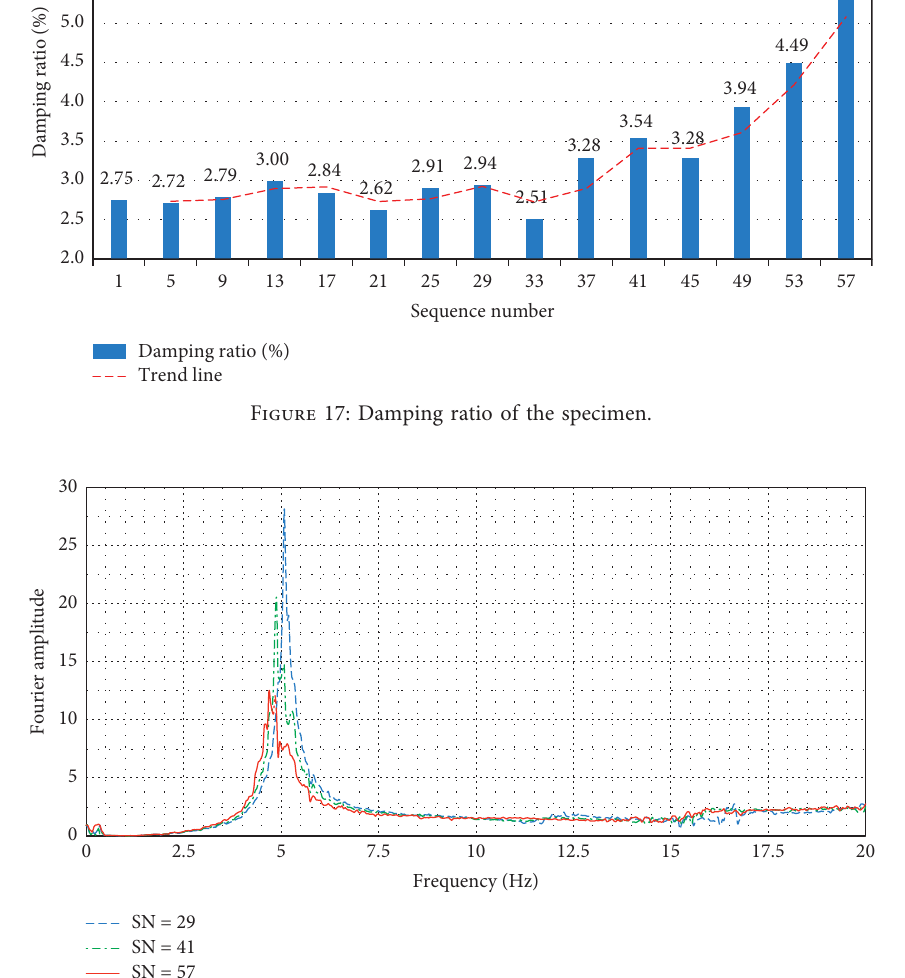
Figure 18: Fourier amplitude and frequency relation of the specimen.